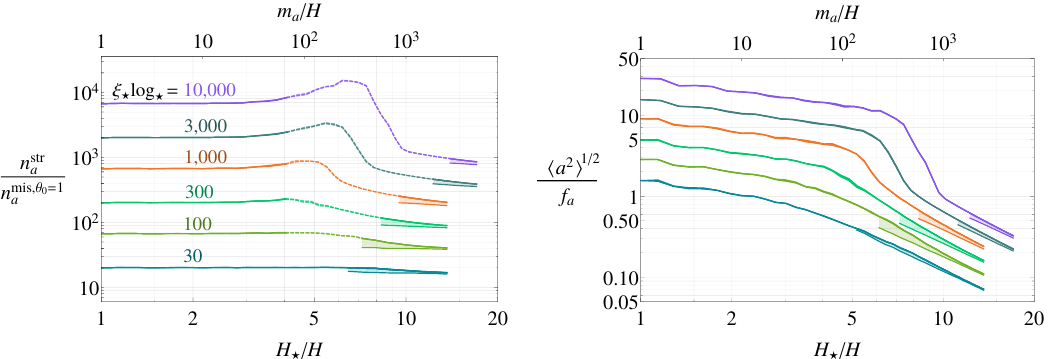
= 10 and 0 (cid:63) log (cid:63) as on